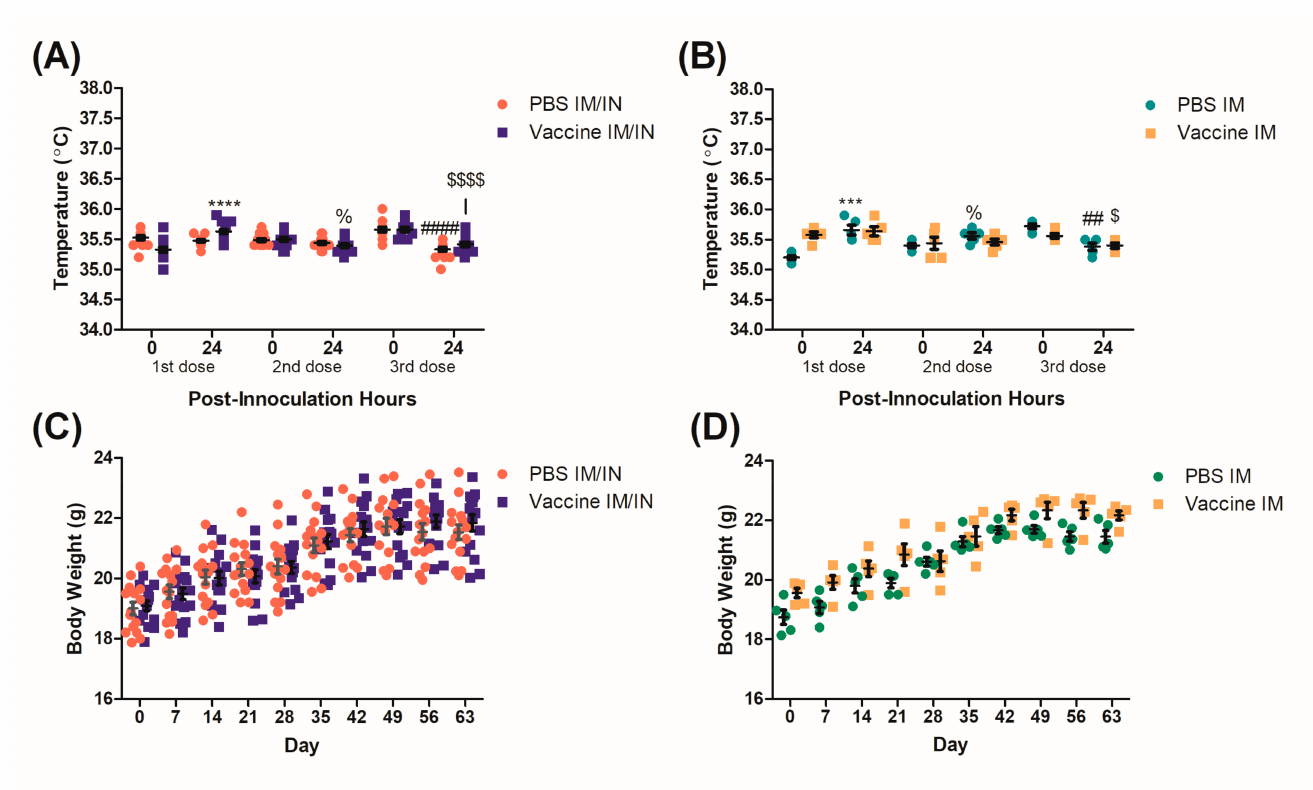
Figure 1. Clinical observations of BALB/c mice during the vaccination protocol. Female BALB/c mice had corporal temperatures recorded immediately before and 24 h after each ( A ) intramuscular (IM)/intranasal (IN) vaccination or ( B ) IM vaccination event. Mice were also weighed once a week starting on day 0 (first vaccination) until day 63 of the vaccination protocol for the ( C ) IM/IN vaccinated and the ( D ) IM vaccinated mice. Data for each figure are represented as ± SEM, ( A ) and ( C ) n = 15, ( B , D ) n = 5 for each group. Statistical analyses for ( A ) were determined by an unpaired two-tailed T-test, % p = 0.0255 and ****, ####, $$$$ p < 0.0001 as compared to the 24 h prior measurement for each dose, respectively. Statistical analyses for ( B ) was determined by an unpaired two-tailed T-test for % p = 0.0285, ## p = 0.012, *** p = 0.0007 as compared to the 24 h prior measurement for each dose/group respectively and a Mann–Whitney U-test for $ p = 0.0442 as compared to the 24 h prior